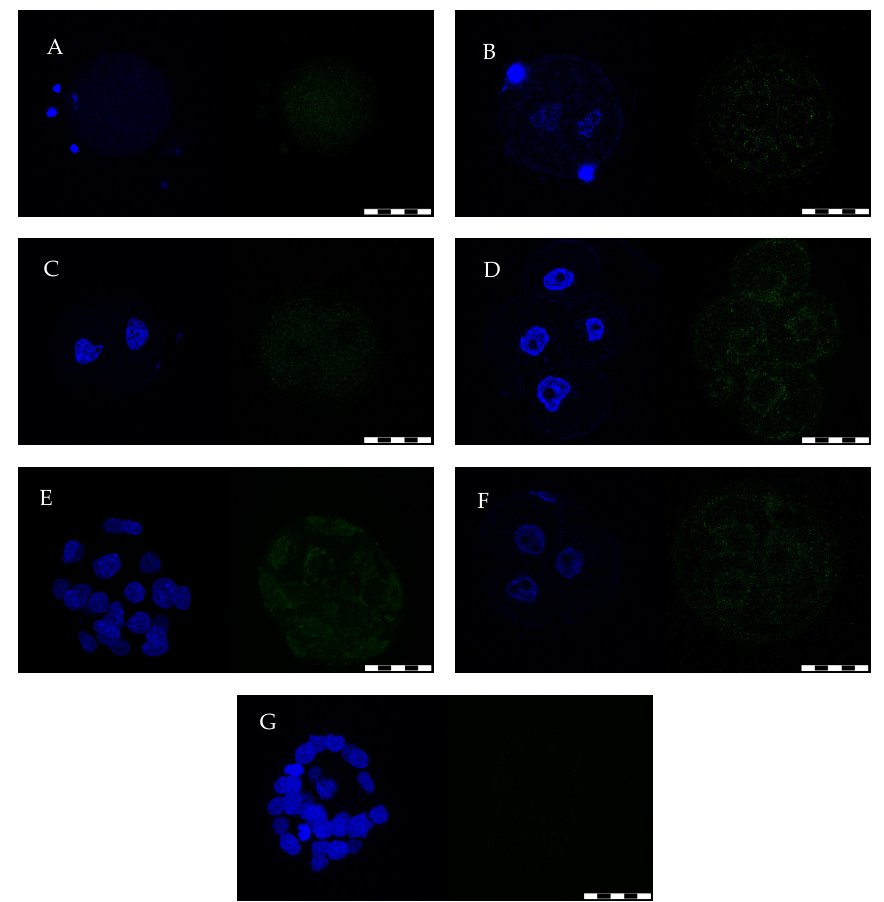
Figure 1. GPx8 presence in rat oocytes and preimplantation embryos detected under a confocal microscope. The left part of each picture shows nuclear material identified by Hoechst 33342; the right part of each picture shows the enzyme identified by an anti-GPx8 antibody conjugated with fluorescein isothiocyanate (FITC). Protein in unfertilized oocytes ( A ) was dispersed homogeneously in cytoplasm while in zygotes ( B ) and 2-cell embryos ( C ), it concentrated into many granules. Moreover, the protein was also detected in the cytoplasm of corona radiata cells; three of them are still attached to the left side of the oocyte ( A ). On the other hand, the protein was not detected in the head of sperms, two of which are attached to opposite sides of the zygote’s surface ( B ) but are blurred due to the different focusing positions compared to zygote’s pronuclei. Protein from 4-cell embryonic stage ( D ) till blastocyst ( E ) and even in the degenerated embryo ( F ) was predominantly observed in the area surrounding nucleus of each blastomere. Degenerated embryo here is represented by a 3-cell embryo isolated on D5 from the uterus, where the head of sperm is still attached to the upper surface of the zona pellucida. Control embryo ( G ) represents blastocyst on D5 after omitting antibodies against GPx8. Original magnification: × 400. Scale bar: 50 µ